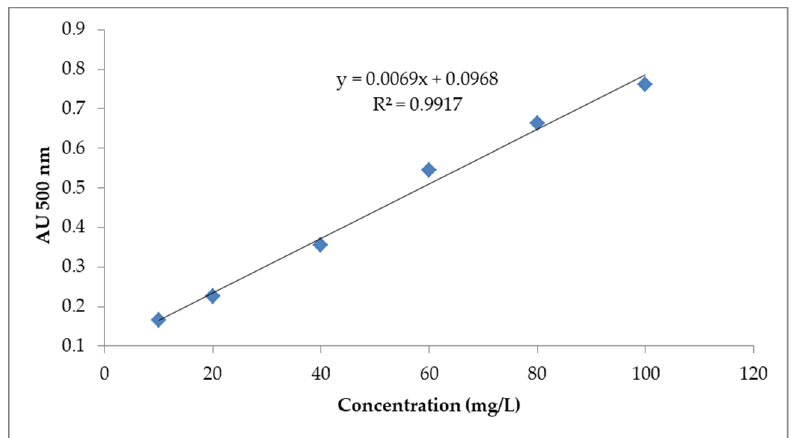
Figure A1. Standard curve for quinizarin at 470 nm.